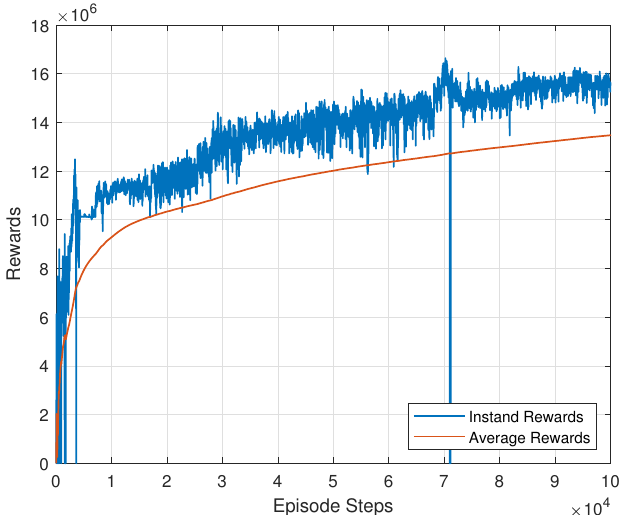
Figure 7. Received rewards versus episode steps.